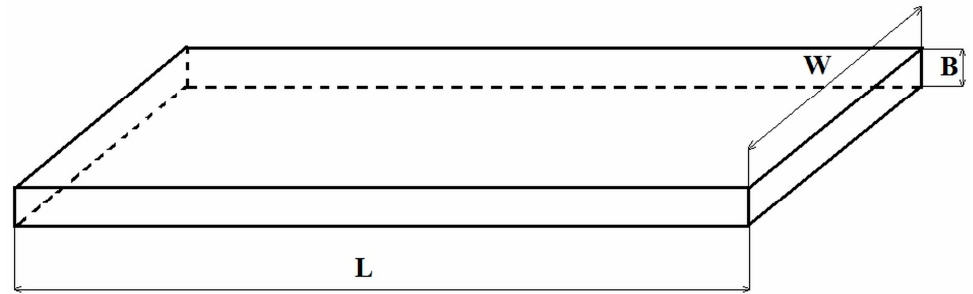
Figure 1. A schematic of the specimens used for flexural strength determination. Then, the specimens were divided to several batches (Table